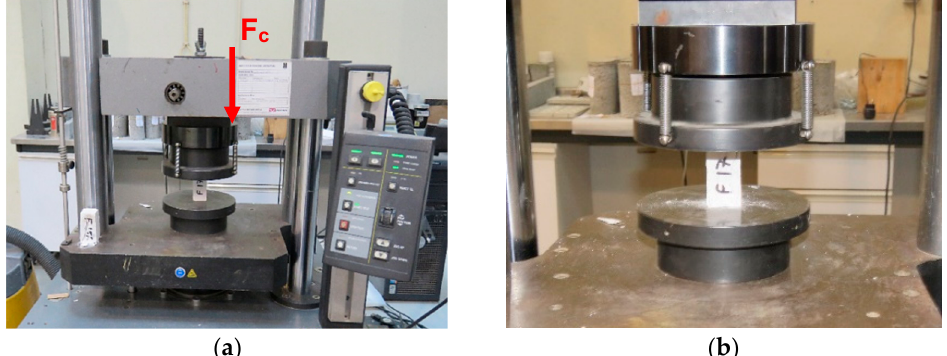
Figure 7. Examples of compressive strength lab tests: ( a ) test set-up with loading direction; ( b ) specimen after breaking load.